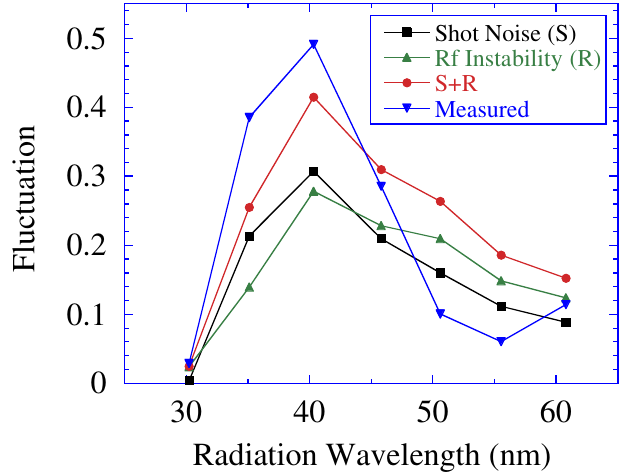
FIG. 15. (Color) Comparison of the measured fluctuation depen- dence with that of the 3D SASE FEL simulations. The black, green, and red symbols represent the simulated fluctuation dependences by shot noise ( S ), rf instability of the accelerator ( R ), and sum of S and R , respectively. The blue symbols represent the measured dependence.